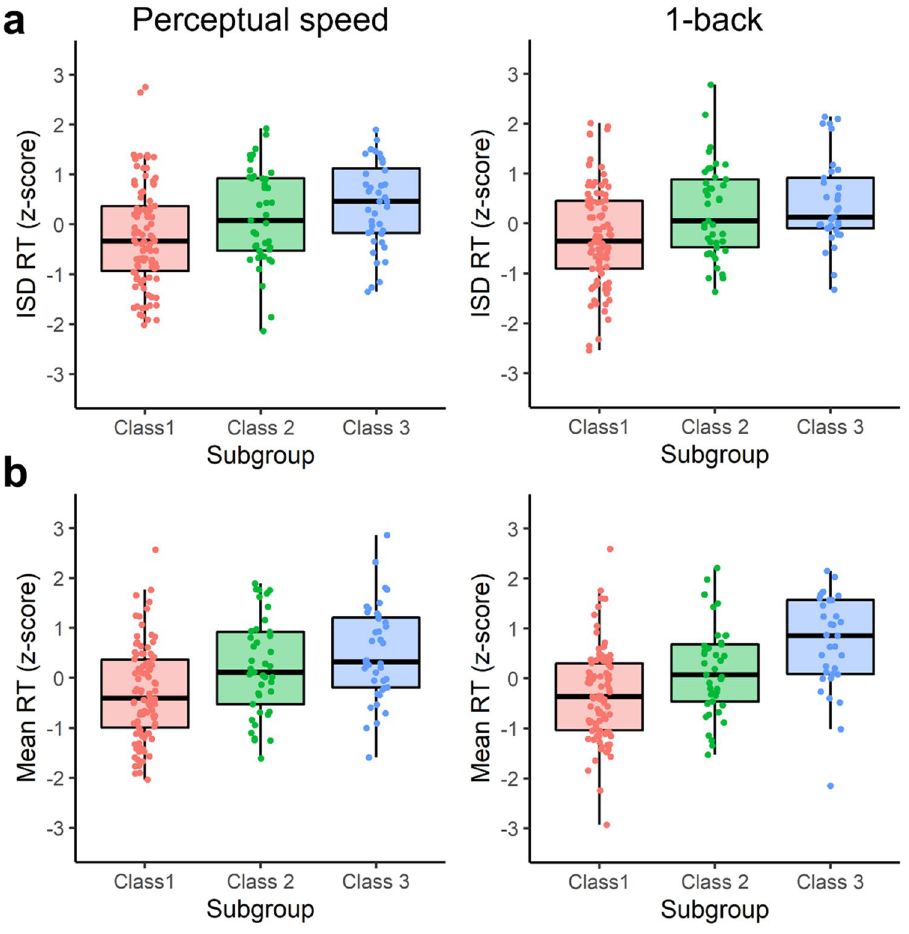
Figure 1. Intra-individual variability in reaction time (RT) ( a ), and mean RT ( b ) in each sample subgroup (Class 1 = high cognition, high D2DR availability; Class 2 = low cognition, low D2DR availability; Class 3 = low cognition, high D2DR availability 60 ). Boxplots display the median and upper and lower quartile, and error bars the largest/smallest value within the 1.5 interquartile range from the upper/lower